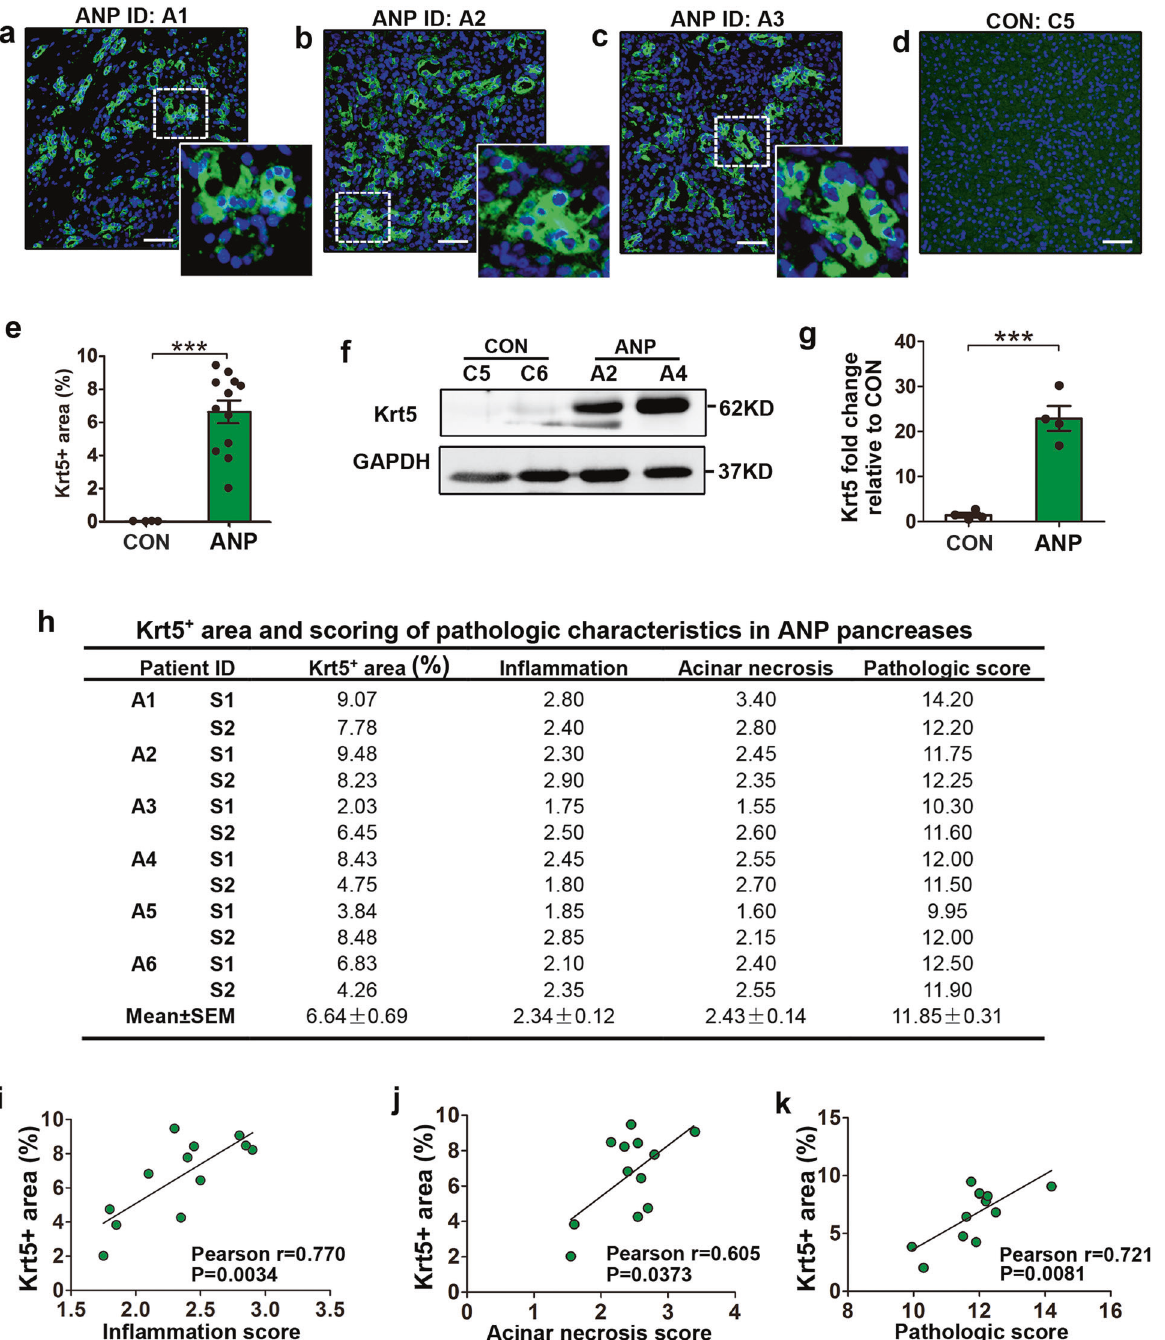
Fig. 2 Krt5 + cells are activated in pancreases of ANP patients and correlate with the pancreatic injury. a – d Representative images of pancreases from ANP and control individuals immunostained with Krt5 (green) and DAPI (blue) showing massive Krt5 + cells activation following ANP. e Quanti fi cation of the area covered with Krt5 + cells in control and ANP pancreases, divided by the total area (shown as %, n = 4 in control group, n = 6 in ANP group with 2 sections per ANP patient). f Representative western blots of Krt5 expression in pancreases from control and ANP individuals. g Quanti fi cation of western blots for Krt5 fold change in ANP pancreases compared with that in control pancreases. h Krt5 + area (%) and scoring of pathologic characteristics of pancreases from ANP patients. Two sections per patient were analyzed. i – k Pearson regression analyses showing the correlation between the Krt5 + area and in fl ammation score ( i ), acinar necrosis score ( j ) and pathologic score ( k ). ANP, acute necrotic pancreatitis; CON, control. Data are mean ± SEM, n = 4 – 6. *** p < 0.001. Scale bars, 50 μ